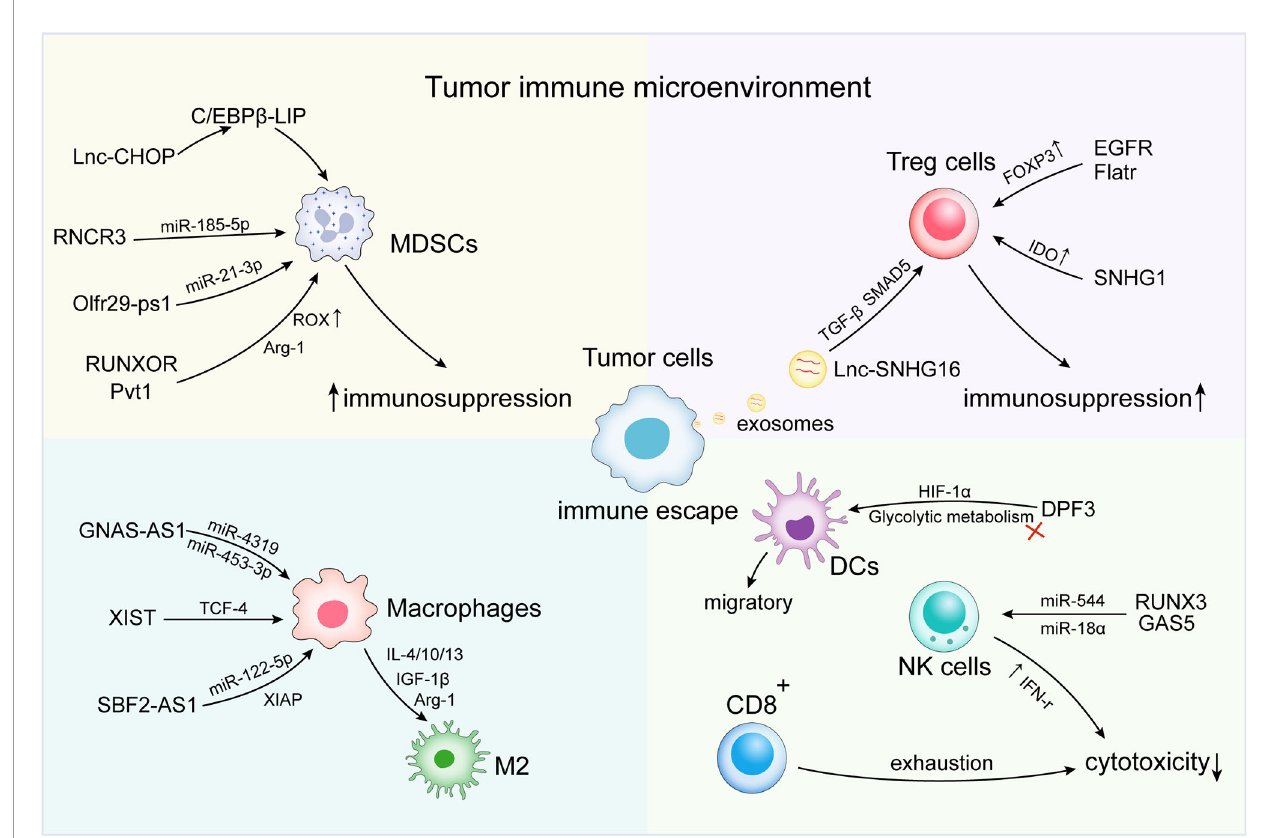
FIGURE 1 | Long non-coding RNAs (lncRNAs) regulate immune escape in the tumor immune microenvironment (TIME). At the microenvironmental level, lncRNAs are involved in mediating and controlling various immune and cancer cell interactions, promoting the activation of immunosuppressive cells and factors [e.g., myeloid- derived suppressor cells (MDSCs) and tumor-associated macrophage (TAMs) subsets]. Abnormal antitumor immune cells [e.g., dendritic cell (DC), natural killer (NK) cells, and T cells] and regulatory cells T cells (Tregs) induce the formation of an immunosuppressive microenvironment, thus contributing to the immune escape of tumor